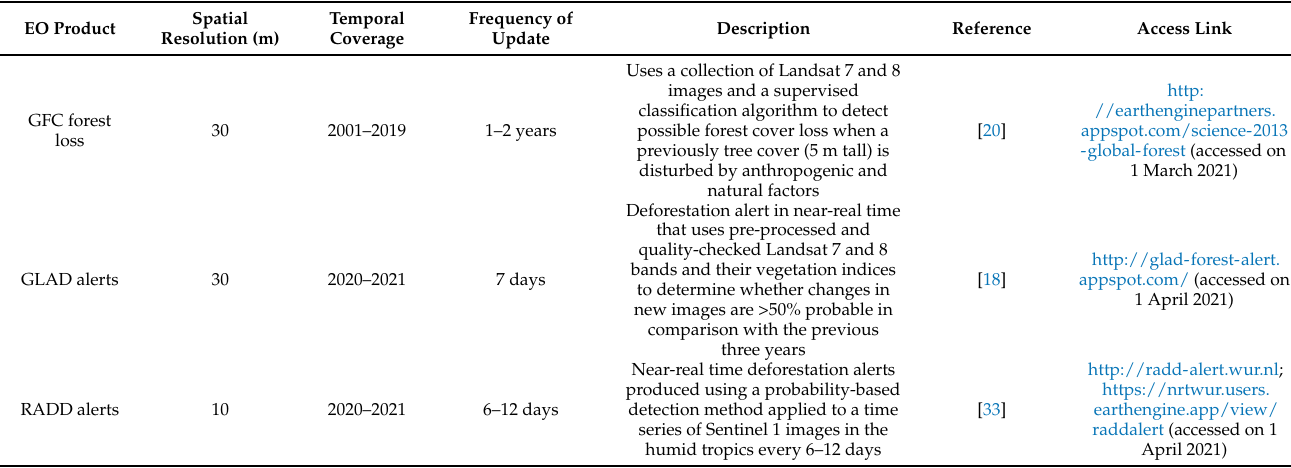
Table 1. Deforestation datasets we used and their key details including their spatial and temporal properties, brief methodology, references and data download